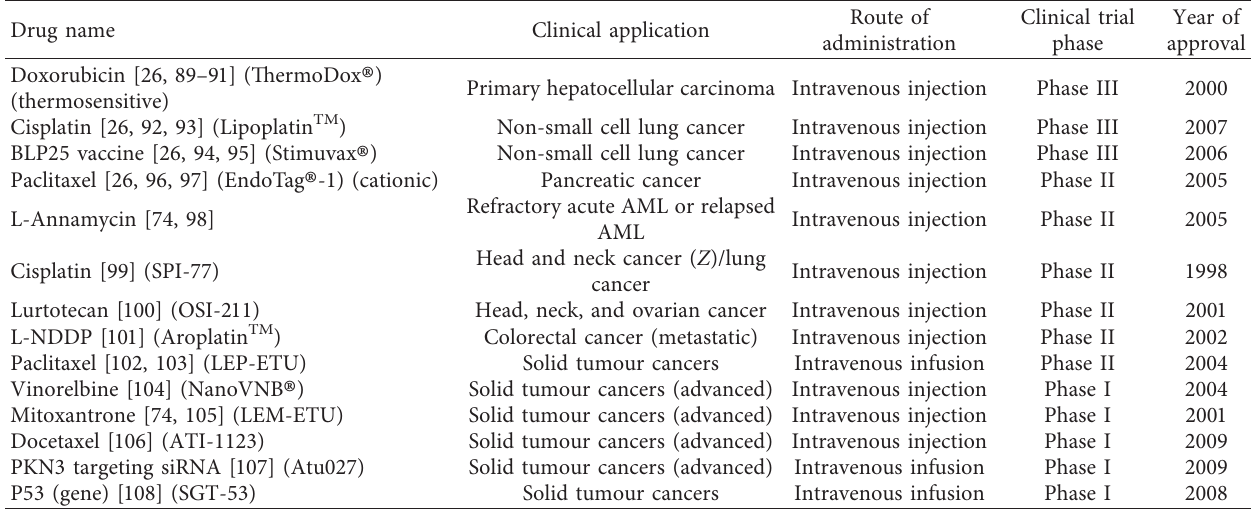
Table 3: An illustration of liposomal products in varying clinical trial phases yet to be approved with their intended clinical application and preferred administration